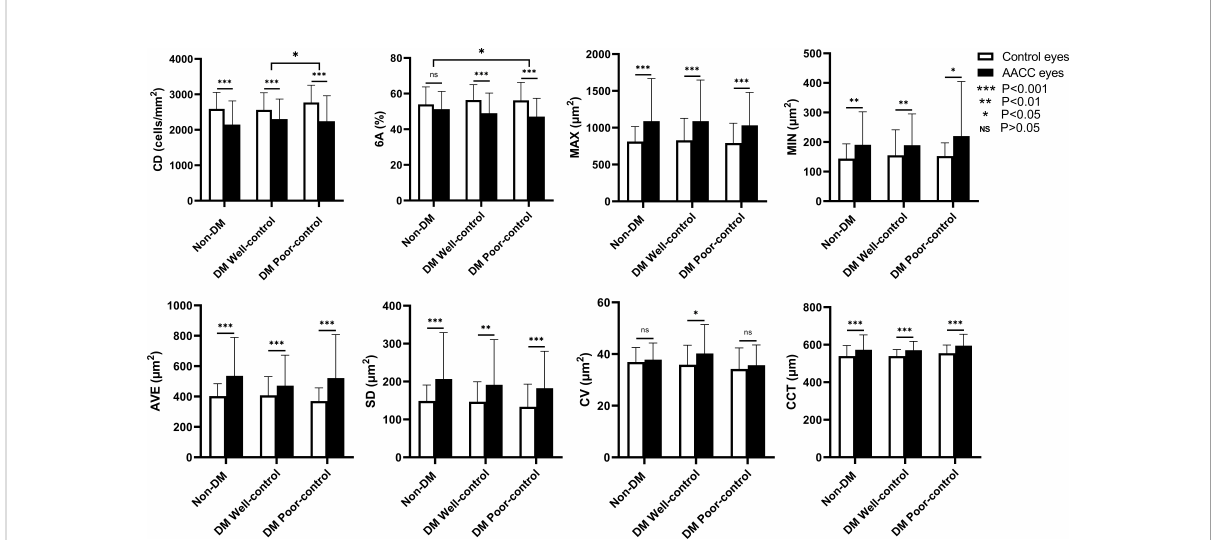
FIGURE 1 The Corneal Parameters of Acute Angle Closure Crisis (AACC) Eyes and Control Eyes in Study Groups. AACC, acute angle closure crisis; DM, diabetes mellitus; CD, cell density; 6A, percentage of hexagonal cells; MAX, maxmum cell area; MIN, minimun cell area; AVE, average cell area; SD, standard deviation of average area; CV, coef fi cient of variation of average area; CCT, central corneal thickness. The changes of CD, 6A, MAX, MIN, AVE, SD and CCT in each group were statistically signi fi cant. CV, known as the descriptive data, was not statistically signi fi cant in non-DM group and DM poor-control group.The CD loss rate between DM well-control group and DM poor-control group was statistically signi fi cant. The 6A decline rate between non-DM group and DM poor-control group was statistically signi fi cant.